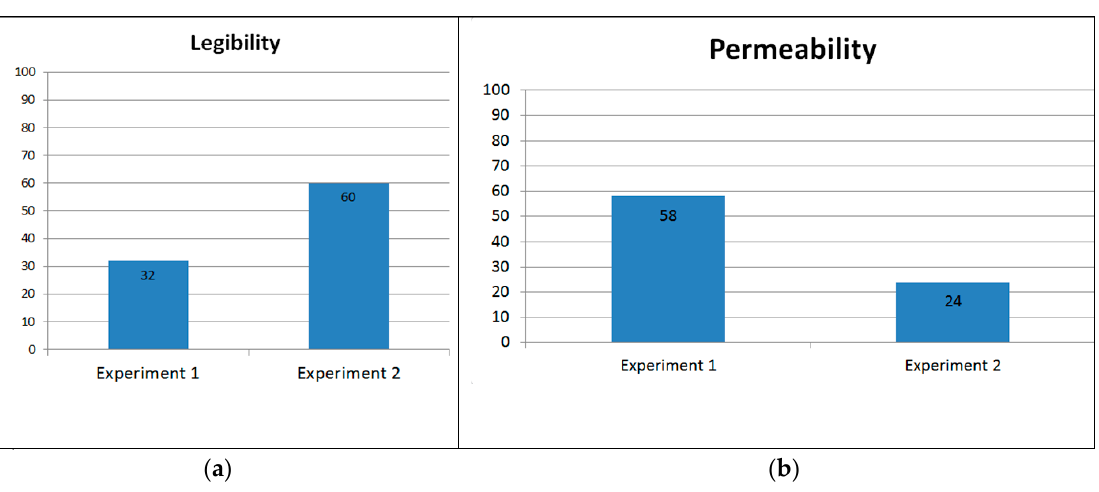
Figure 13. Experiments 1 and 2 outputs compared to spatial analyses of ( a ) legibility; and ( b ) permeability (numbers refer to percentages of street lengths).